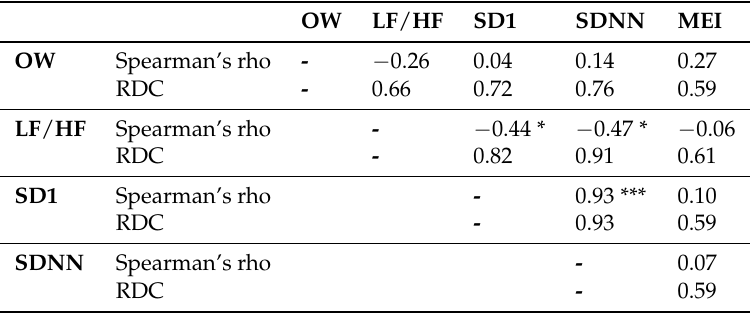
Table 3. Correlation Matrix for TO segment.